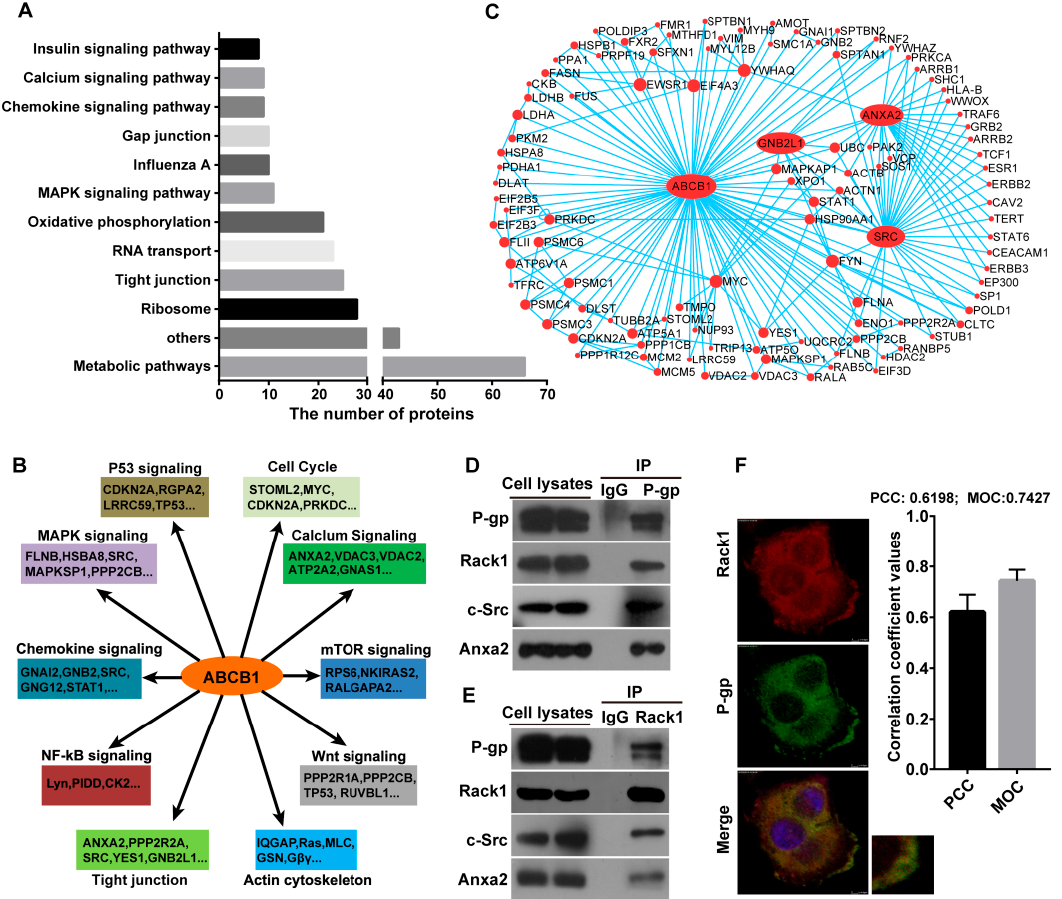
Figure 2. Functional characterization and validation of candidate P-gp interacting proteins identified that Rack1 was a novel binding protein of P-gp. ( A ) Identified P-gp interacting proteins were categorized by signal pathway in Kyoto Encyclopedia of Genes and Genomes (KEGG) database; ( B ) The association of the major P-gp binding proteins with cellular signaling pathways involved in cancer; ( C ) Network of P-gp interacting proteins. A total of 108 P-gp interacting proteins were mapped via protein-protein interaction databases searches using the VisAnt software and visualization in Cytoscape; only proteins that interact with at least two other proteins are shown. Nodes represent proteins; lines represent interactions; and node size indicates the interaction degree; ( D ) Co-immunoprecipitation assay showed that endogenous P-gp interacted with endogenous Rack1, c-Src and Anxa2 in drug-resistant breast cancer cells. MCF-7/ADR cells were lysed, immunoprecipitated with anti-P-gp antibody and then analyzed by western blotting with anti-P-gp, Rack1, c-Src or Anxa2 antibody; ( E ) Endogenous Rack1 interacted with endogenous P-gp, c-Src and Anxa2 in breast cancer cells. MCF-7/ADR cells were lysed, immunoprecipitated with anti-Rack1 antibody, followed by Western blotting analysis; ( F ) Confocal immunofluorescence microscopy analysis showed that Rack1 was colocalized with P-gp in MCF-7/ADR cells (Red: Rack1, Green: P-gp, Yellow: Merge; 600 × magnification). Image J software (NIH, Bethesda, MD, USA) was used to quantify the colocalization efficiency. The plasma membrane regions of the cells were selected as the region of interest. Both Pearson’s correlation coefficient (PCC) and Mander’s overlap coefficient (MOC) were used to calculate the degree of colocalization between Rack1 and P-gp. Thirty images were analyzed.